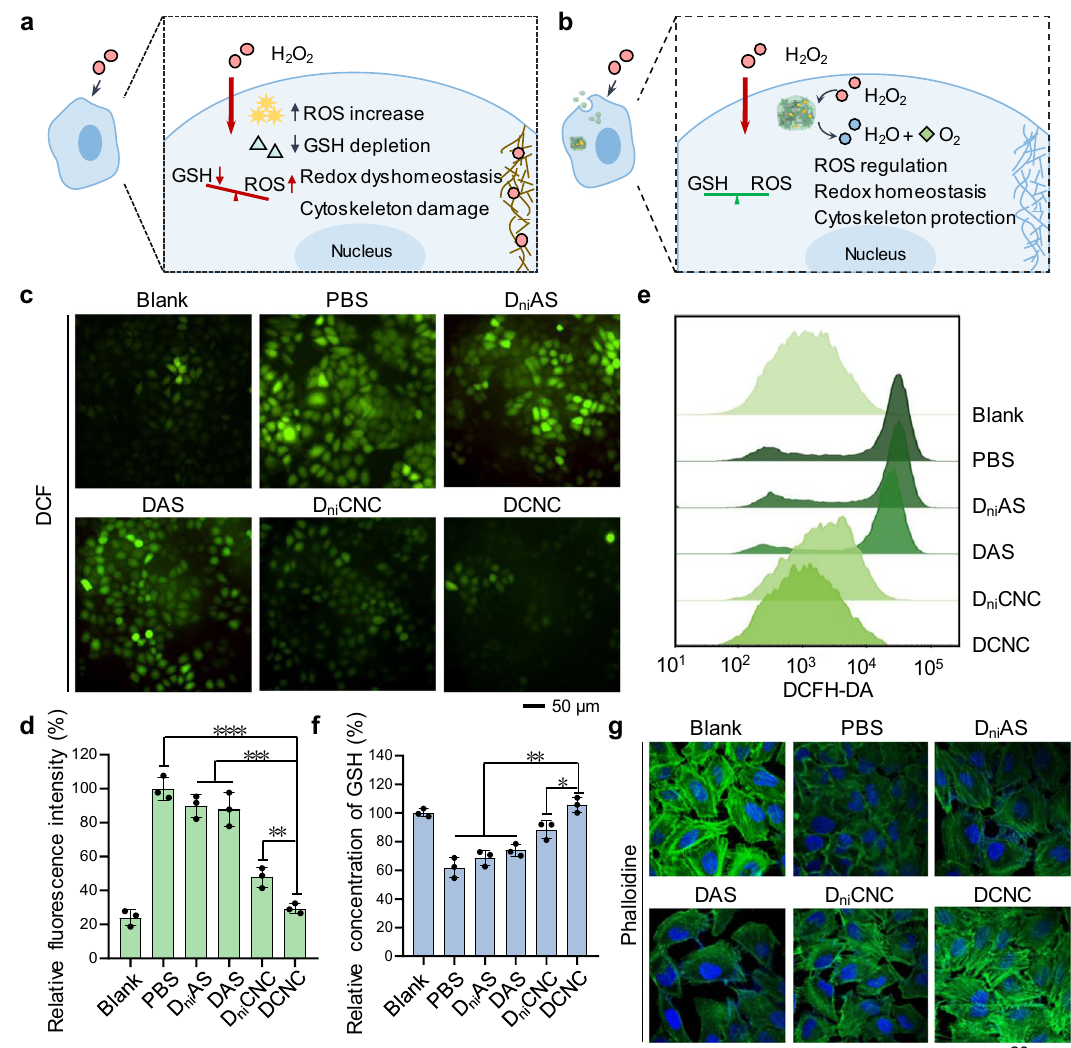
Fig. 5 | ROS regulation effects of DCNC in living cells. a Schematic illustration of cell effects upon the treatment of high-concentration H 2 O 2 . b Schematic illustra- tion cell effects upon the treatment of DCNC and then high-concentration H 2 O 2 . c Representative fl uorescence microscopy images showing ROS levels measured withDCF fl uorescentprobeafterincubationwithdifferentmaterialsandtreatment withH 2 O 2 . d Mean fl uorescenceintensityofDCFanalyzedbyimageJsoftware.Bars represent mean±SD ( n =3 independent samples). (** P <0.01; *** P <0.001; **** P <0.0001, calculated by two-tailed unpaired t test). e Flow cytometry of ROS